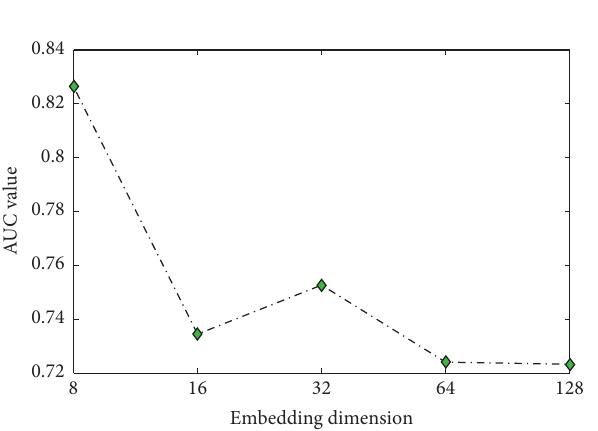
Figure 4: The impact of embedded dimension d .